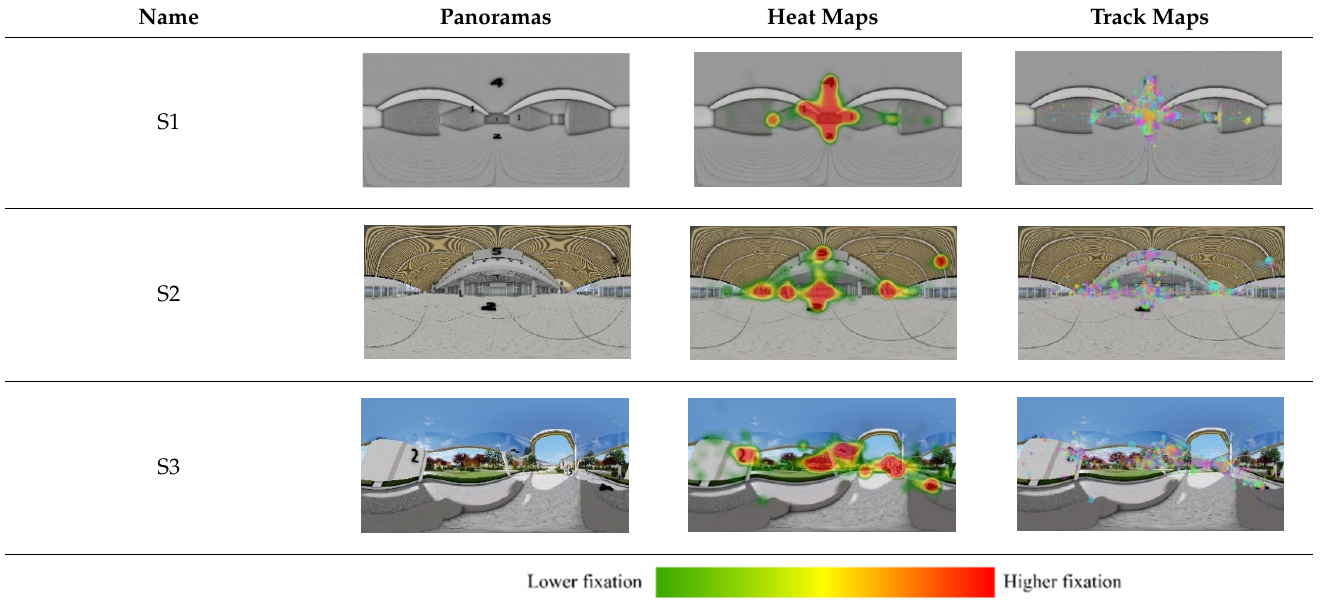
Table 7. Visualization of Eye-Tracking Data by Scene. Table 7. Visualization of Eye ‐ Tracking Data by Scene. Table 7. Visualization of Eye ‐ Tracking Data by Scene. Table 7. Visualization of Eye ‐ Tracking Data by Scene. Table 7. Visualization of Eye ‐ Tracking Data by Scene. Table 7. Visualization of Eye ‐ Tracking Data by Scene. Table 7. Visualization of Eye ‐ Tracking Data by Scene. Table 7. Visualization of Eye ‐ Tracking Data by Scene. Table 7. Visualization of Eye ‐ Tracking Data by Scene.